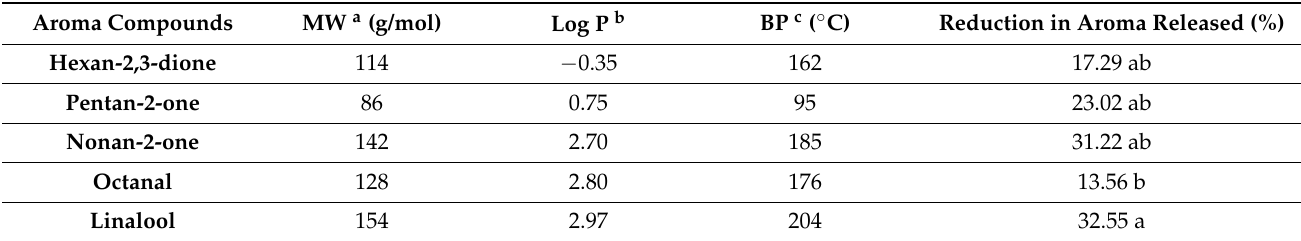
Table 1. Physicochemical characteristics of the aroma compounds assayed and reduction in the quantity of aroma released due to the addition of oligofructose, expressed as a percentage.